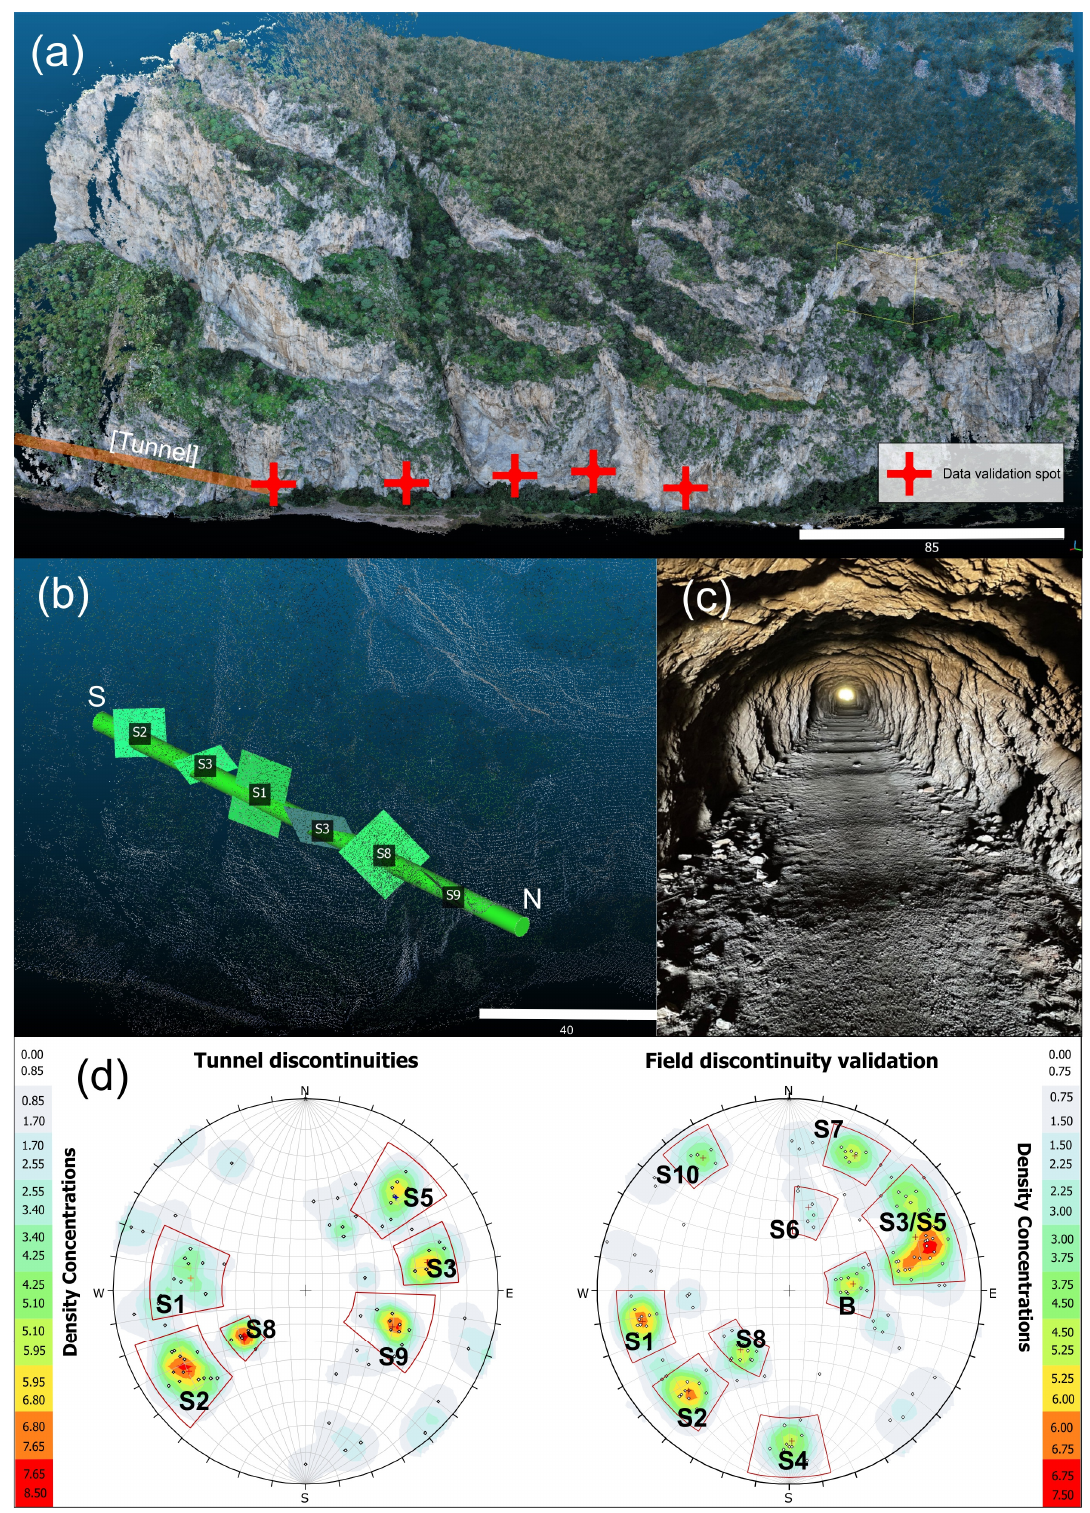
Figure 5. ( a ) Location of data validation spots; ( b ) tunnel underground development highlighted in the 3D slope model with indication of the major discontinuity planes crossing it. Planes were graphically plotted on the tunnel model by Cloud Compare software, which allowed reproducing a georeferenced plane according to field measurements; ( c ) photo of the inner tunnel; ( d ) validation stereograms based on field-surveyed data.